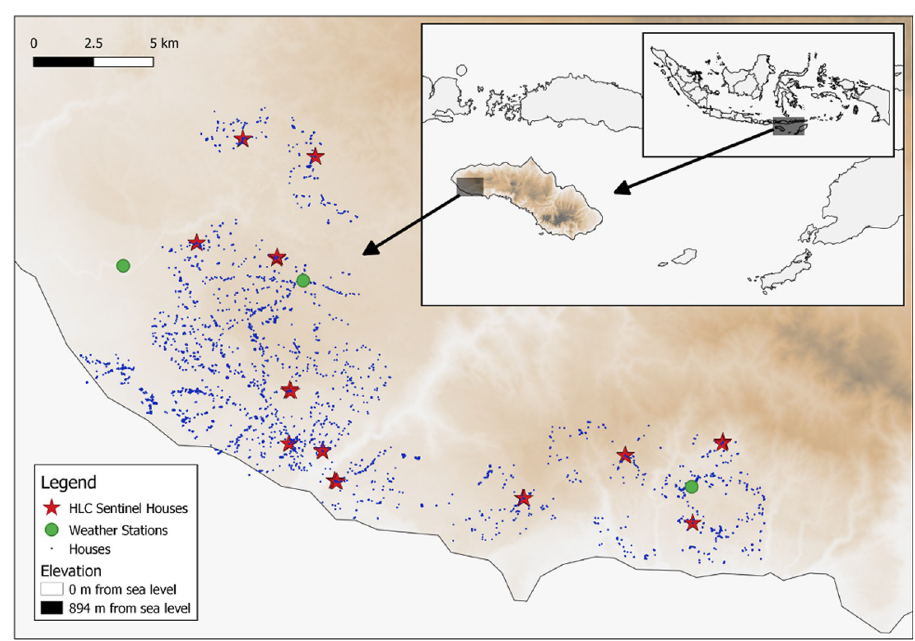
Fig 1. Map of the study site: 4 sentinel houses in each clusters are marked by stars. A map depicting the location of study site in Southwest and West Sumba Districts, East Nusa Tenggara Province, Indonesia (http://www.